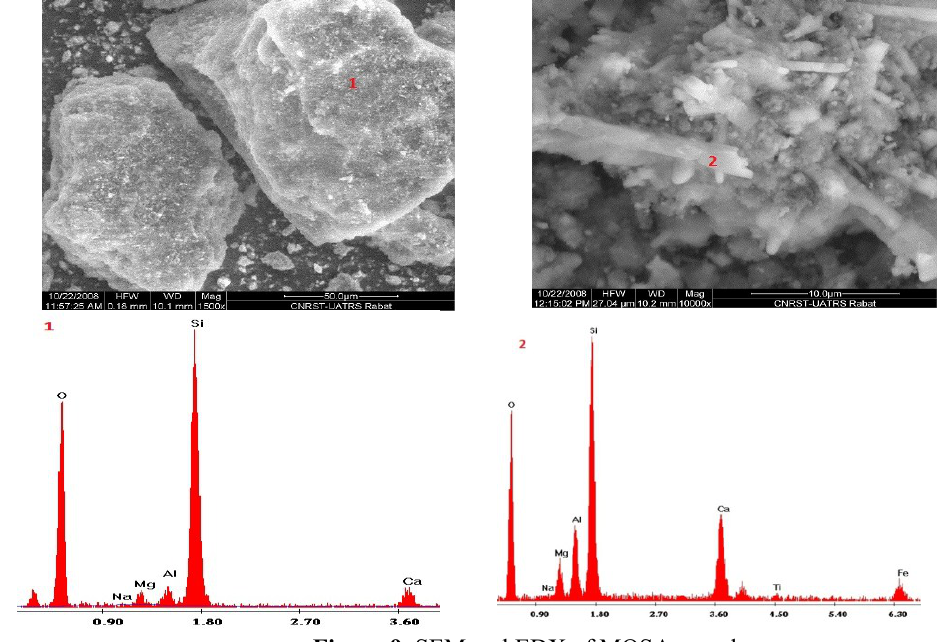
Figure 9. SEM and EDX of MOSA